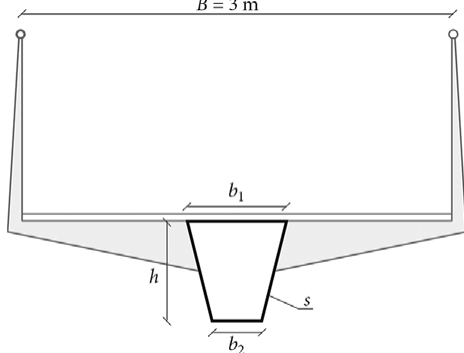
Fig. 5. Cross section of the prototype footbridges